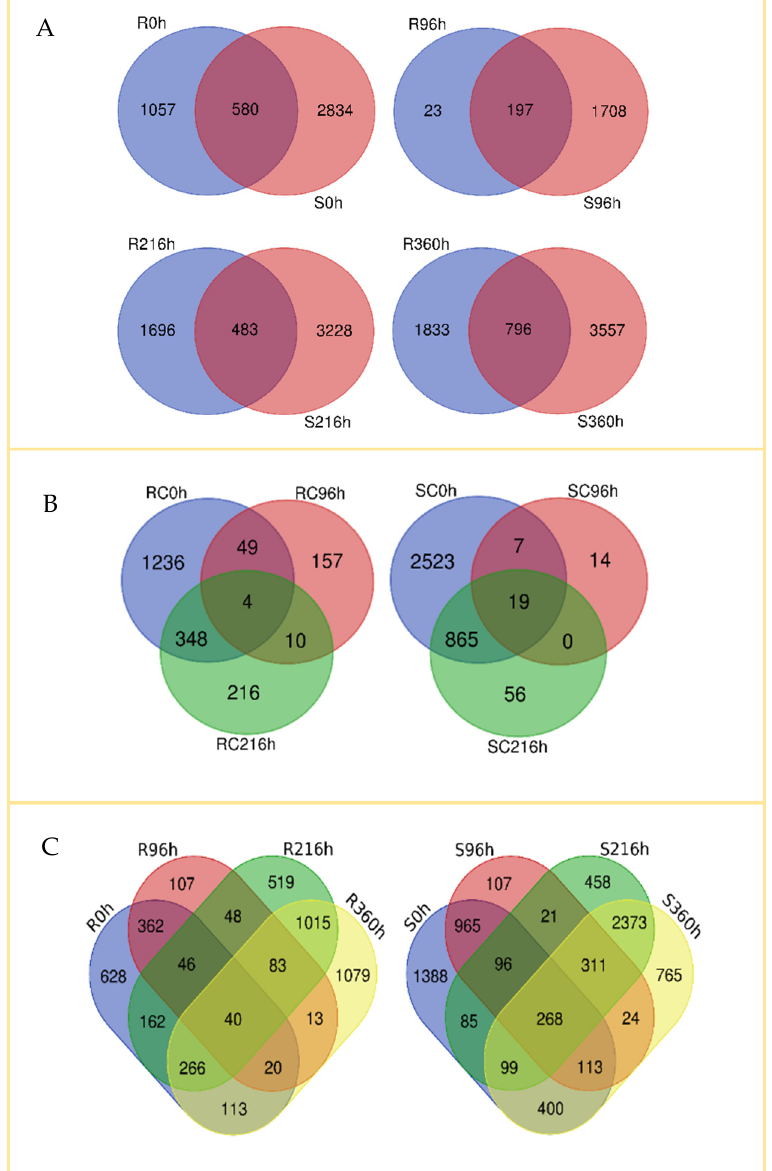
Figure 3. Venn diagram showing differences and commonalities in gene expression of resistant (TAM428, R) and susceptible (Tx2737, S) sorghum lines at different time points (0 h, 96 h, 216 h, and 360 h) after each plant was infested with five fourth instar nymphs of sugarcane aphid at the 3-leaf stage. Differentially expressed genes for each comparison were quantified by |log 2 fold changes| ≥ 1 and p -value < 0.05. Number of differentially and commonly expressed transcripts ( A ) between R and S sorghum lines at same time point, ( B ) between time points for untreated control, and ( C ) between time points for R and S lines post infestation.